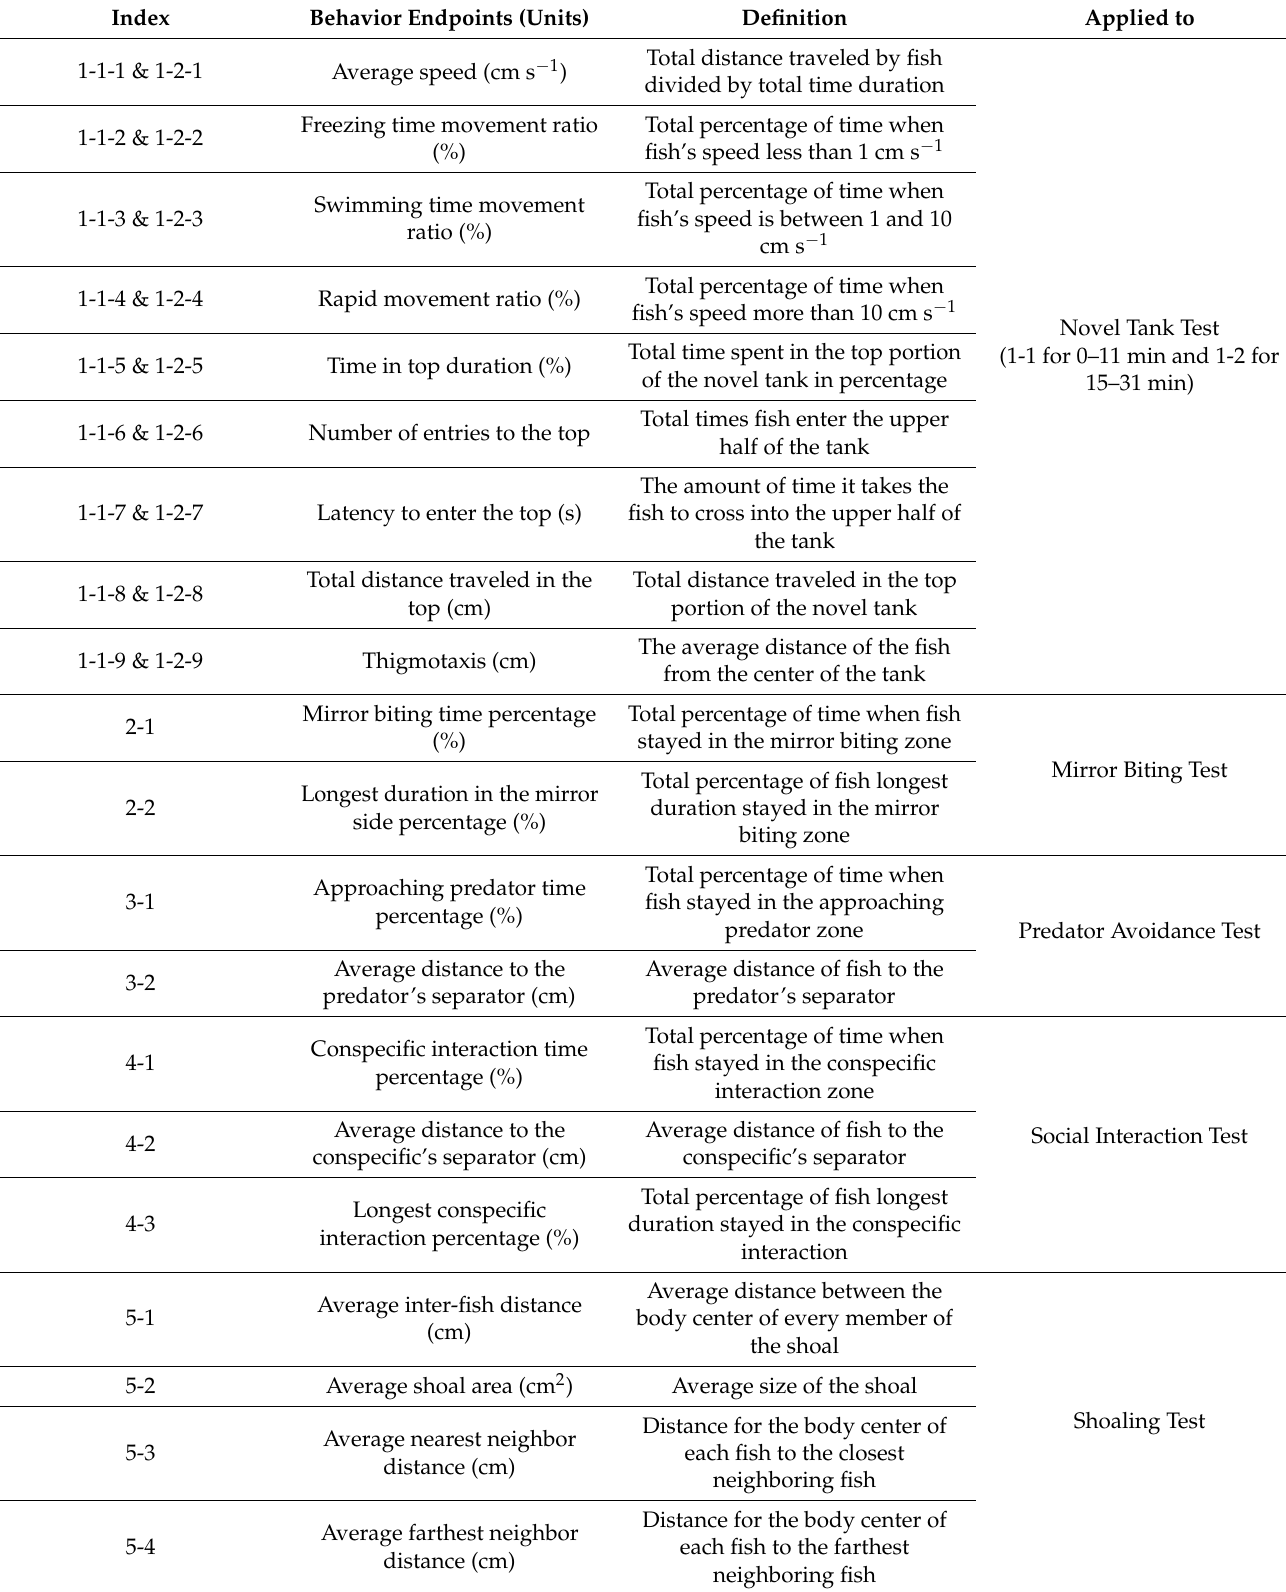
Table A4. Summary of fish behavioral endpoints measured in each behavioral test during this